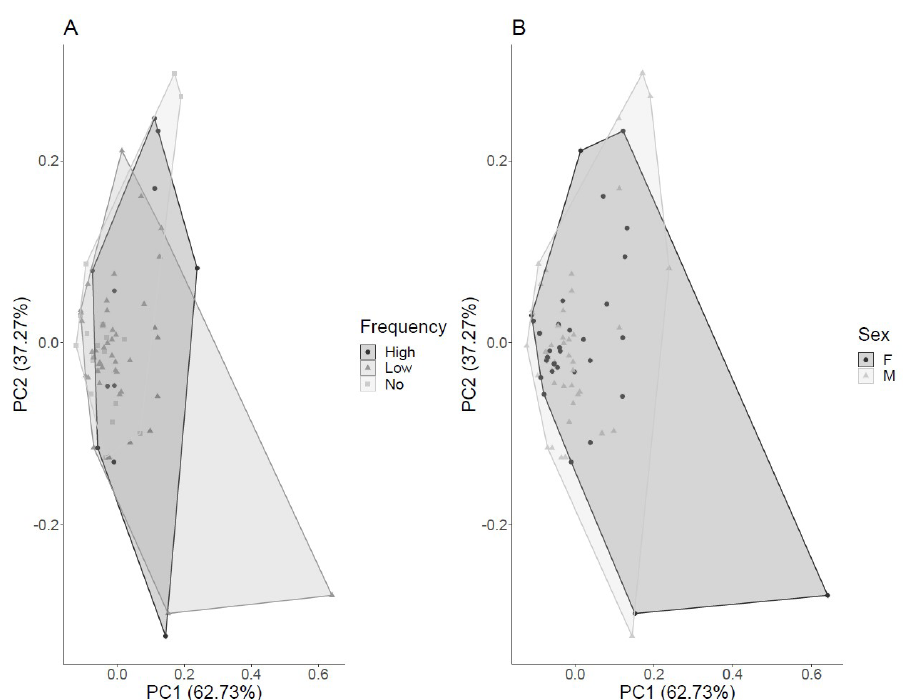
Figure 7. Principal Component Analysis regarding the correlation between people’s perception and chlorophyll-a concentration of questions obtained in the pictures experiment. The polygons represent the groups of people classified by the frequency of visits to aquatic environments (A) and gender (B). The frequency of visits was classified in: no visit, low frequency, and high frequency. Gender was classified into Male (M) or Female (F). Formal education was classified into Basic (B), Graduate (G), and Undergraduate